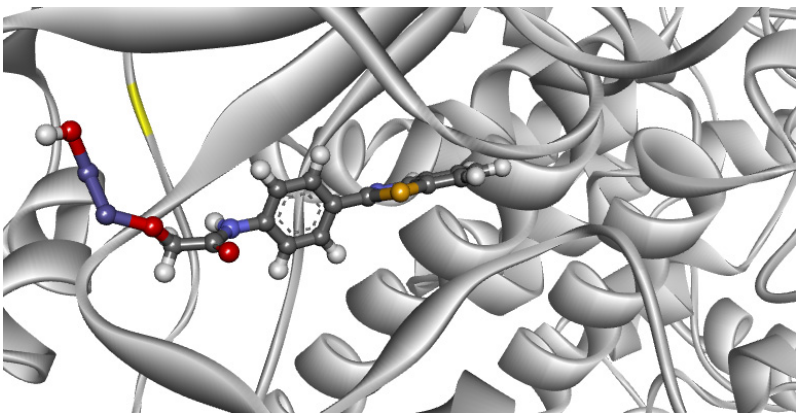
Figure 9. The ABT/ δ -FeOOH complex within the PI3K enzyme site. To better analyze the molecular interactions that occurred during the docking simula- tion, Figure 10 was